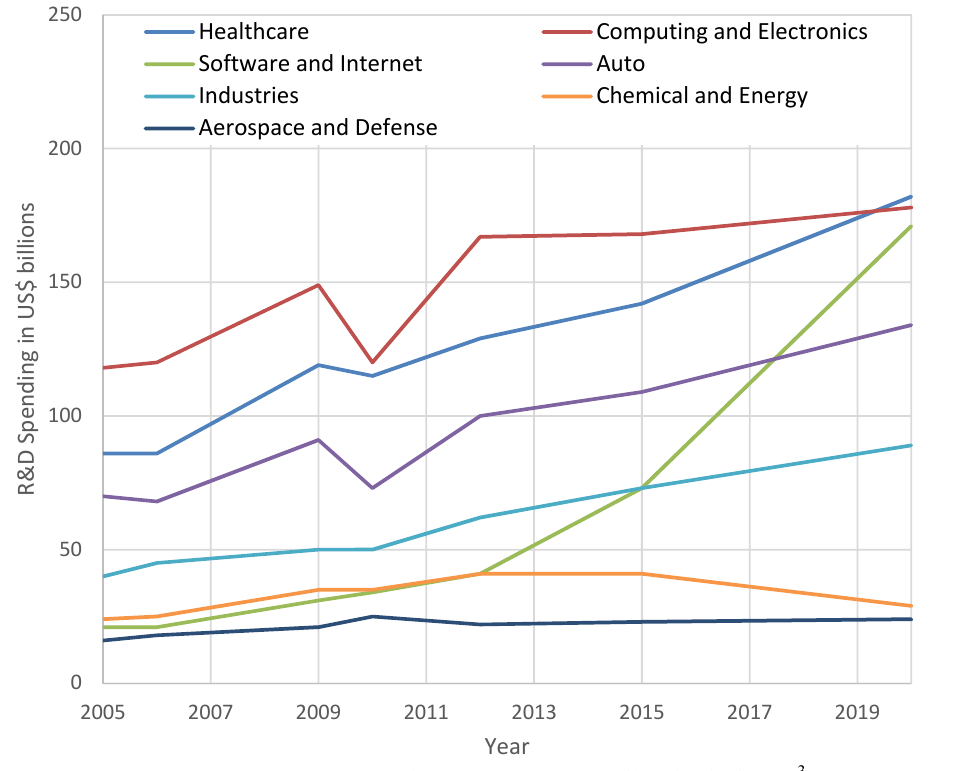
Figure 3. R&D spending by industry